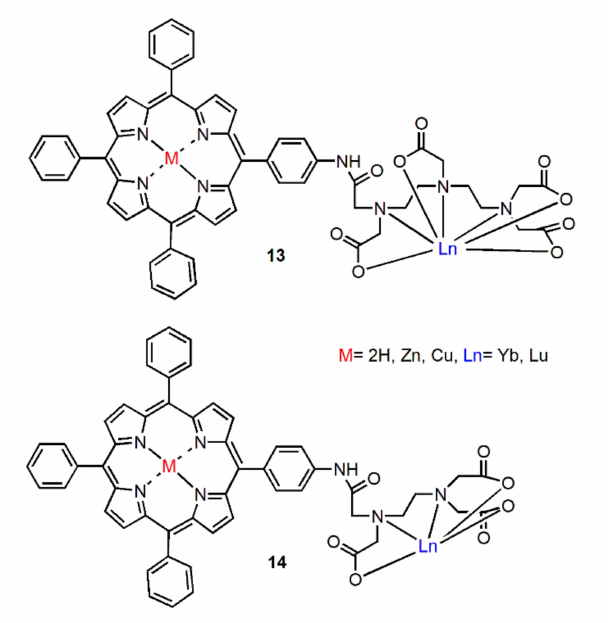
Figure 5. Structures of complexes 13 and 14 . Adapted from ref. [41].